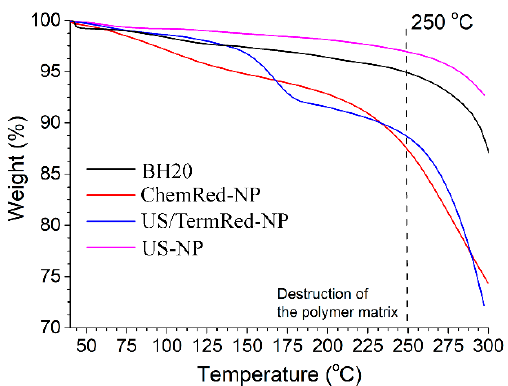
Figure 4. TG analysis of hyperbranched polyester BH20 and samples of ChemRed-NP, US/TermRed-NP, and US-NP.